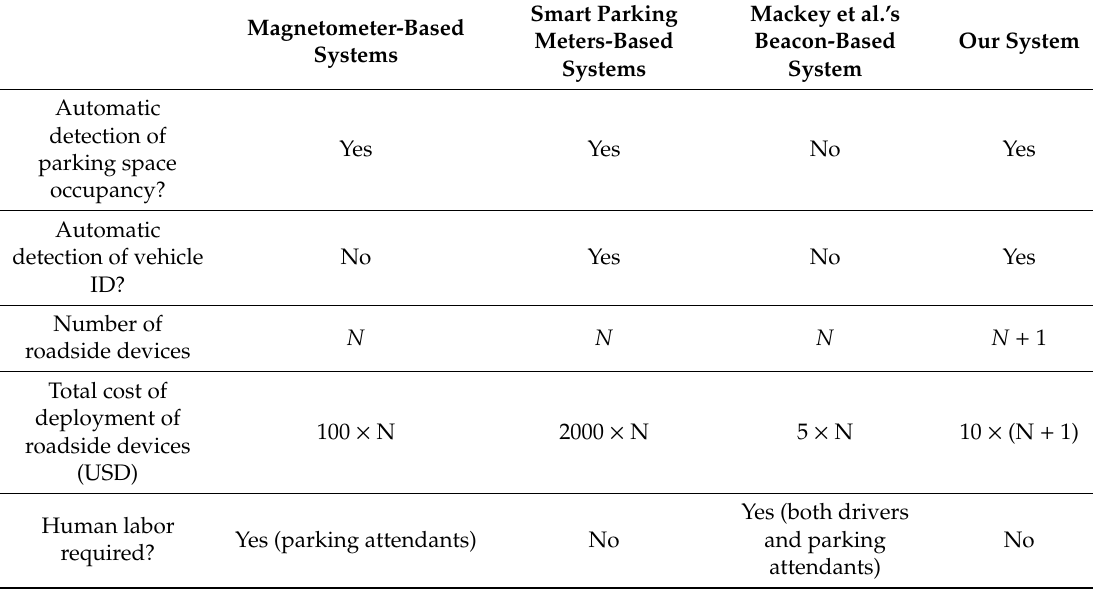
Table 3. Comparison of existing infrastructure-based on-street parking